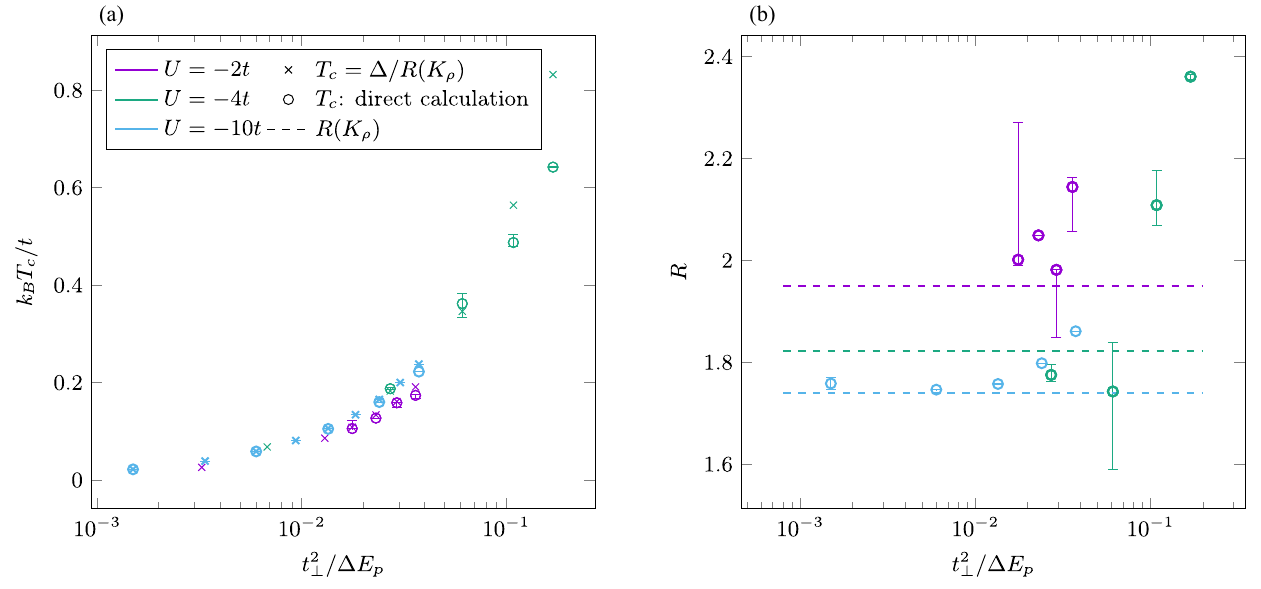
FIG. 11. A comparison of analytical methods and combination with numerical methods for several values of interaction. Panel (a) shows critical temperature T vs transverse tunneling t 2 ⊥ = Δ E . Circles show data obtained via direct calculation of thermal states, c p while crosses show T computed from zero-temperature calculations using the excitation gap Δ and Eq. (40). Panel (b) shows the ratio c R ¼ Δ =T of ground-state excitation gap to critical temperature, both computed separately, compared with the analytical ratio Eq. (40) c . (dashed lines) vs t 2 ⊥ = Δ E p